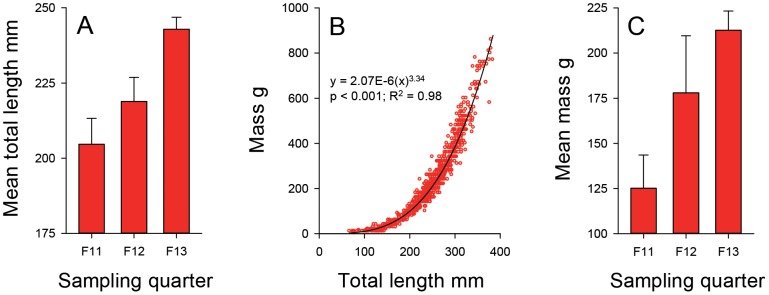
Length to weight relationship of speared lionfish predicts lionfish mass from ROV length observations.A) Mean (95% CI) total length of red lionfish (n = 190) observed in remotely operated vehicle video (ROV) samples at northern Gulf of Mexico reef sites and measured in video images with a red laser scale attached to the ROV; F = fall, 11 = 2011, 12 = 2012, and 13 = 2013. B) Non-linear regression computed to predict red lionfish mass from total length from fish (n = 934) captured by spearfishing. C) Mean (95% CI) predicted mass of lionfish (n = 190) observed in ROV video samples and measured with a red laser scale.